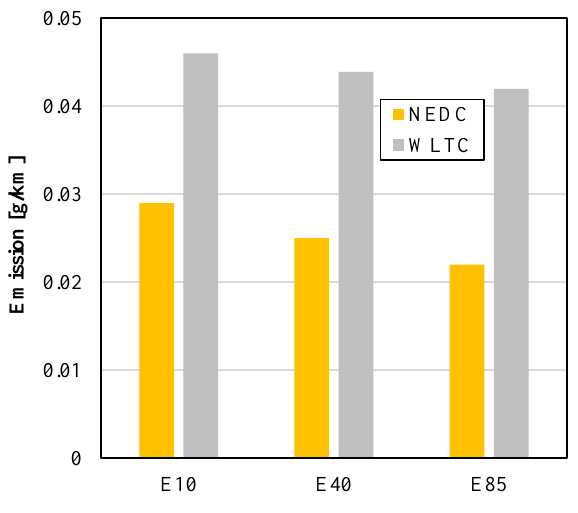
Fig. 6. THC emission values from a vehicle with a SI engine powered by E10, E40 and E85 fuel in the NEDC and WLTC test cycle